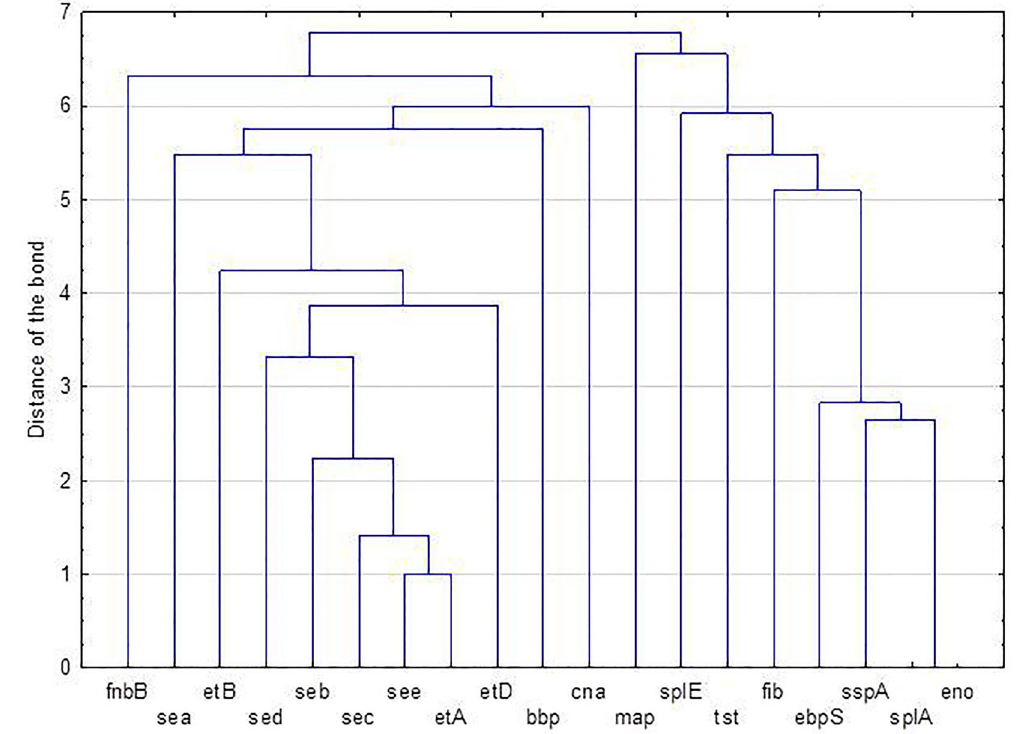
Figure 1. The groups of genes encoding adhesins, proteases and superantigenic toxins in MRSA isolated from patients hospitalized in 2015–2017 created based on the cluster analysis. fnbB , bbp , cna , fib , ebpS , eno —genes encoding adhesins such as fibronectin B-, bone sialoprotein-, collagen-, fibrinogen-, elastin-, laminin-binding proteins, respectively; map —gene encoding Eap (extracellular adherence protein); etA , etB , etD —genes encoding exfoliative toxins; splA , sspA , splE —genes encoding serine proteases; sea , seb , sec , sed , see —genes encoding the enterotoxins A to E; tst —gene encoding the toxic shock syndrome toxin-1.